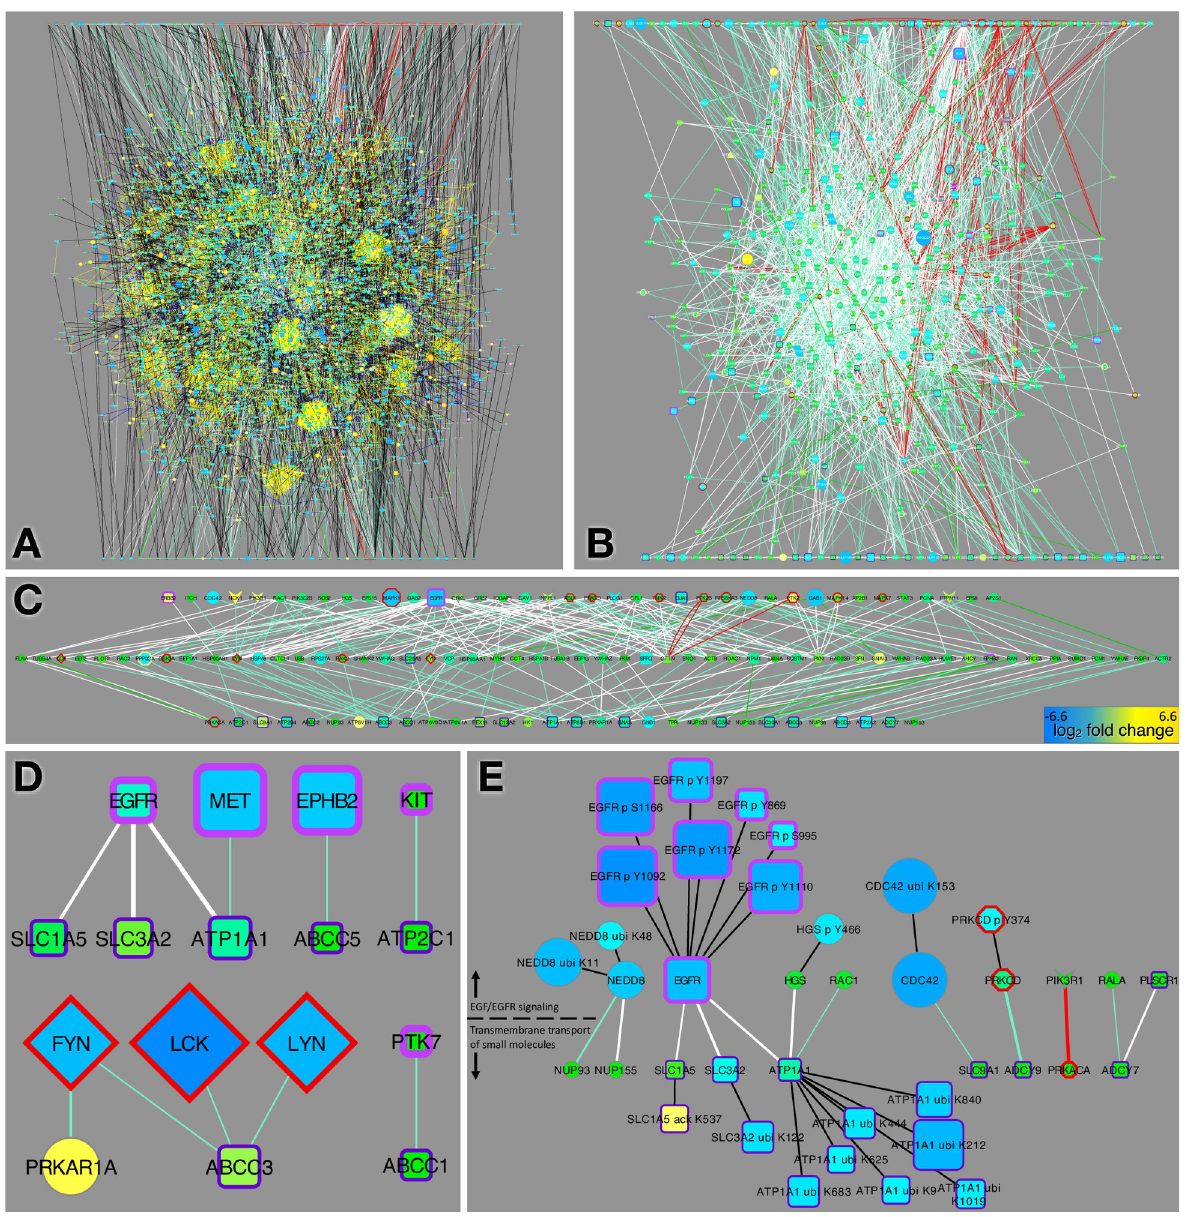
Fig 3. EGFR signaling and small molecule transport pathway interactions. (A) Combined CFN/CCCN showing composite shortest paths from the Bioplanet pathways EGF/EGFR signaling pathway (top row) and Transmembrane transport of small molecules (bottom row). PTM clusters are apparent as cliques connected by yellow correlation edges. (B) same as A but showing CFN edges only. (C) “Mutual friends” (center row) defined as proteins that connect to at least one member of each pathway in the CFN. (D) CFN interactions between RTKs, SFKs and the Transmembrane transport of small molecules pathway. (E) Direct CFN interactions between members of the EGF/EGFR signaling and Transmembrane transport of small molecules pathways. PTMs that were significantly changed ( > 2.25-fold) in response to erlotinib are shown. Node size and color represents the median log 2 fold change in response to erlotinib (A, B, C, E), or dasatinib (D); color scale bar shown in C. Node border and shape and edge colors are defined in S2C